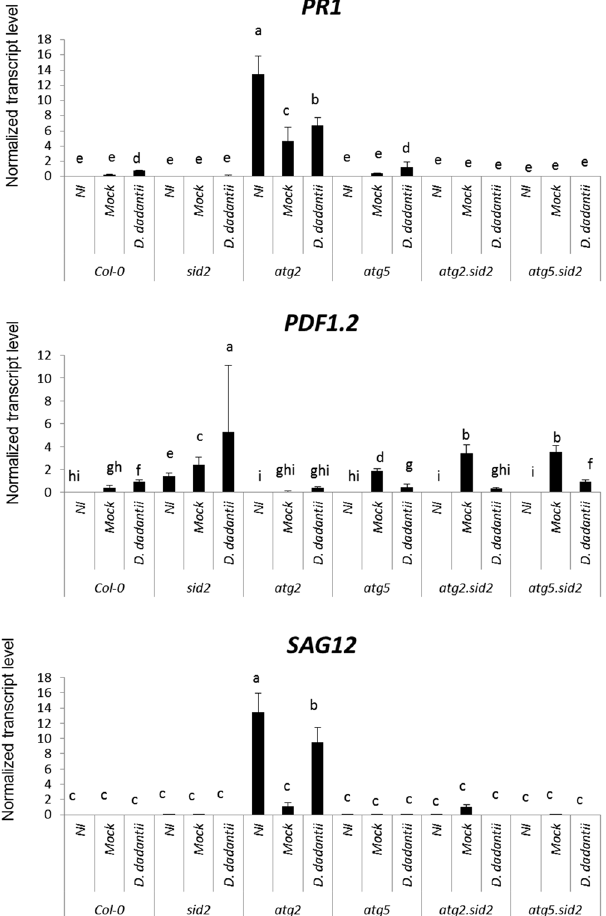
Figure 4. Expression of defense and senescence genes upon D. dadantii infection. Plants were infected or mock treated, leaves were harvested 24 h after treatment. Transcript levels were monitored by qRT-PCR and normalized against the transcripts of the reference genes APT and Clathrin . Bars represent standard deviation. N = 4. Experiments were performed three times with similar results. Different letters in the graph indicate statistical significance between treatments (one-way ANOVA with Tuckey’s test; P < 0.05). NI: Non- inoculated, Mock: treated with MgSO